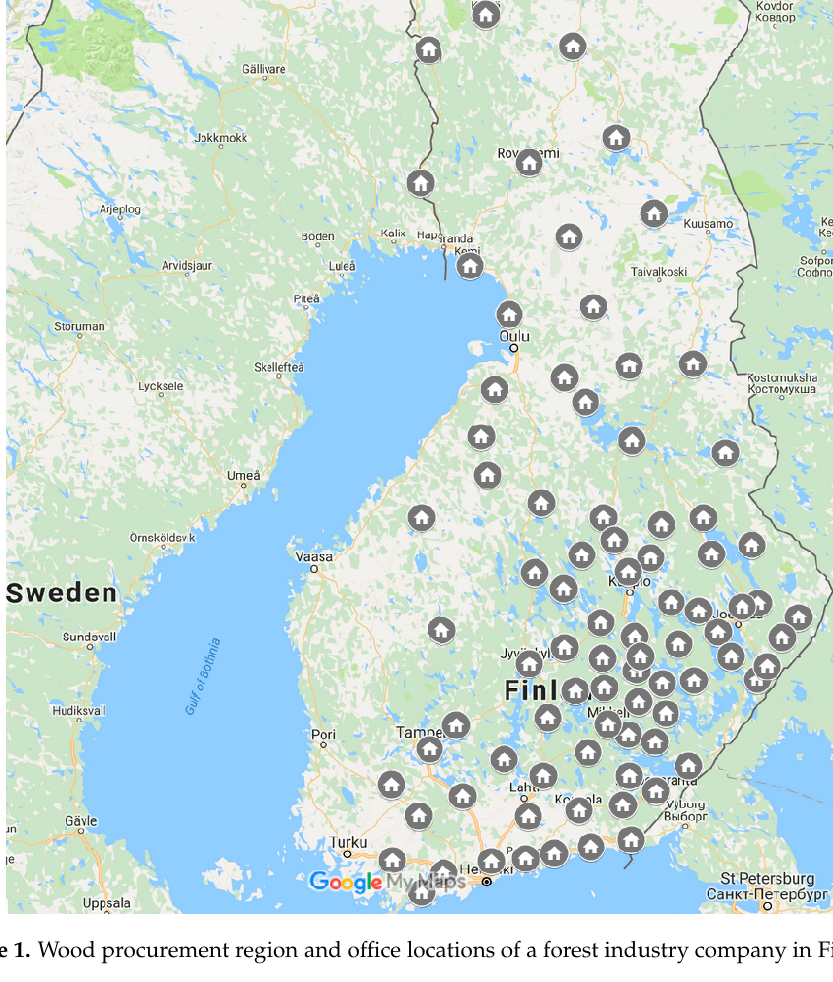
Figure 1. Wood procurement region and office locations of a forest industry company in Finland.